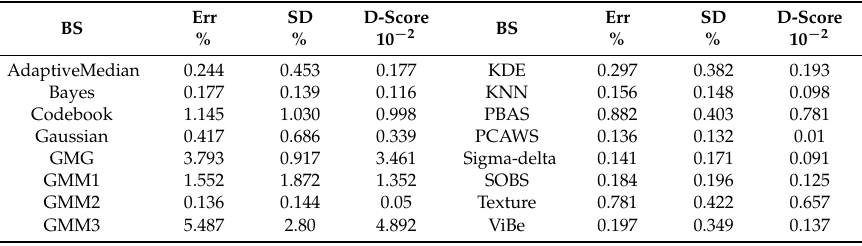
Table 10. Evaluation metrics (Err, SD and D-Score) of the evaluated BS